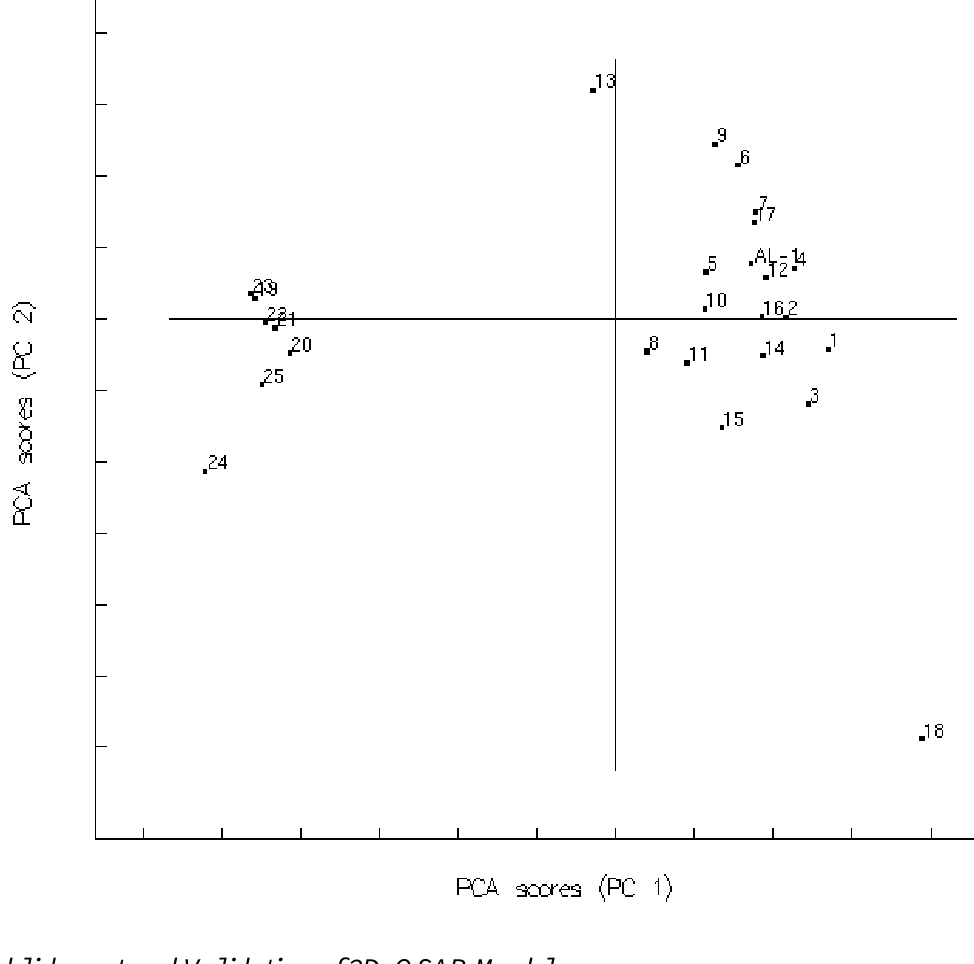
Figure 2. PCA plot for studied compounds 1 – 25